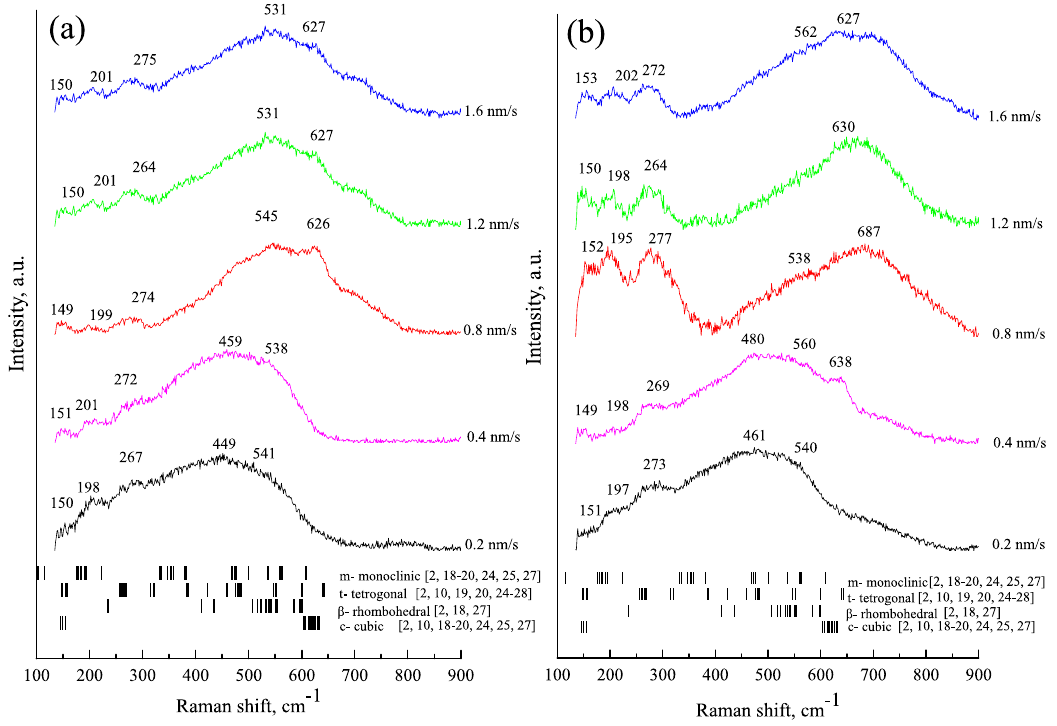
Figure 5. Raman spectra of 6ScAlSZ thin films deposited on Alloy 600 substrates using ( a ) 300 °C and ( b ) 600 °C substrate temperature and different deposition rates from 0.2 to 1.6 nm/s.